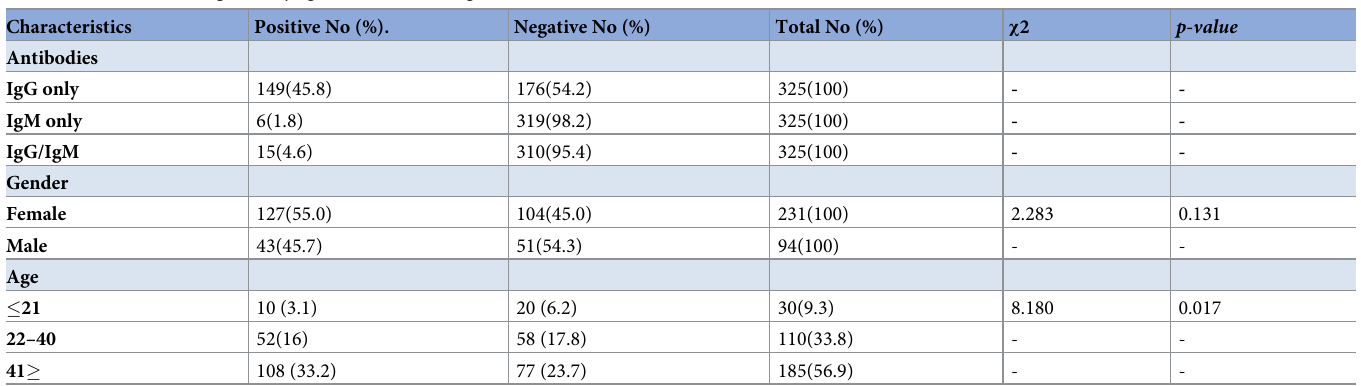
Table 1. Prevalence of T . gondii by age, antibodies, and gender in the BHD.